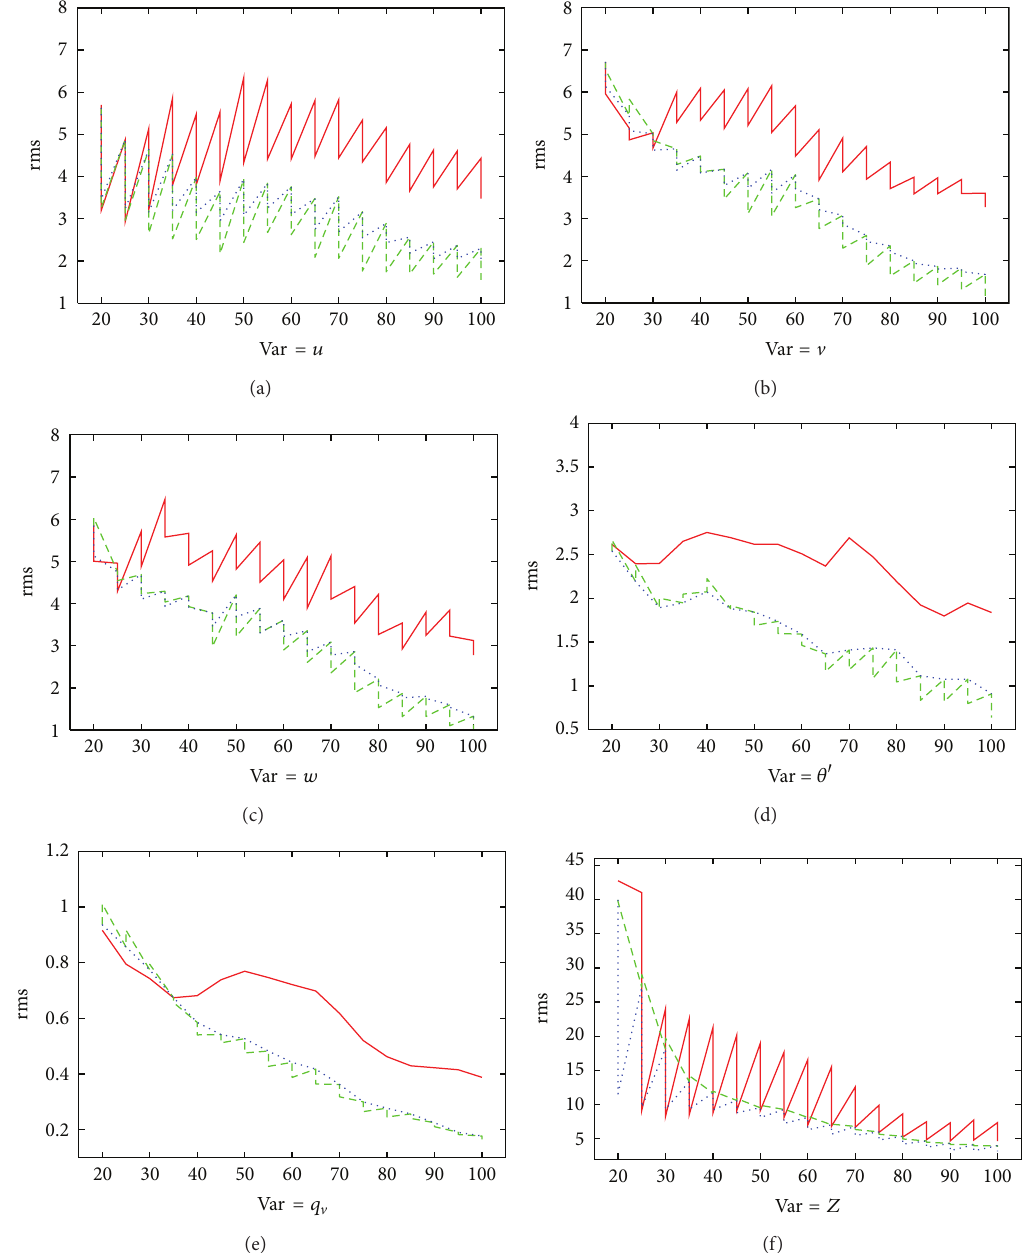
Figure 4: The rms errors of the analysis and forecast for the 3DVAR, (red) EnKF, (green) hybrid EnKF-3DVAR, (blue) methods averaged over points at which the reflectivity is greater than 10 dBZ for (a) 𝑢 -wind component, (b) V -wind component, (c) vertical wind speed, (d) potential temperature, (e) water vapor mixing ratio, and (f)